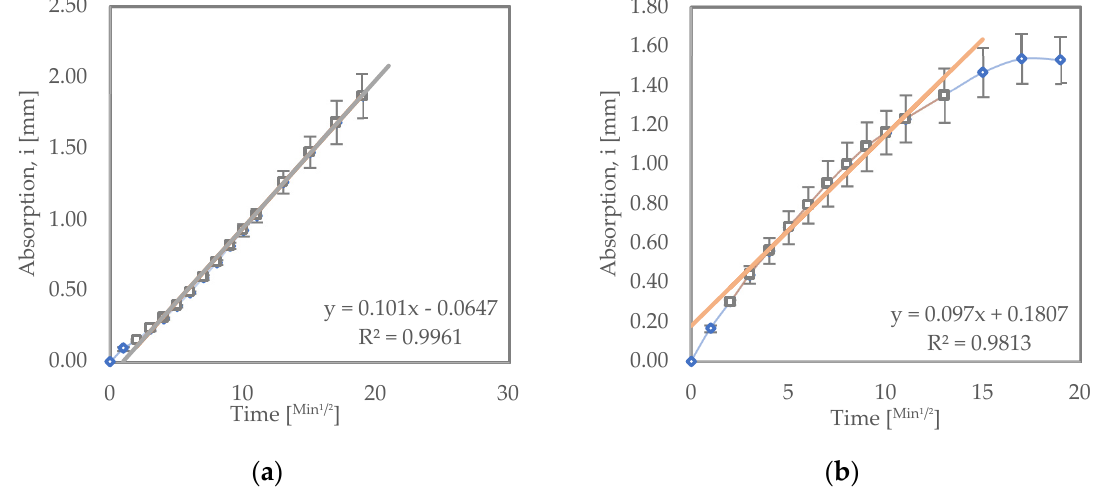
Figure 5. Sorptivity results for ( a ) OPC and ( b ) LC 3 samples immersed in a 5% sodium sulfate solution. √ (9.7 × 10 − 2 mm/ s) compared to LC 3 cured in water (1.46 × 10 − 2 mm/